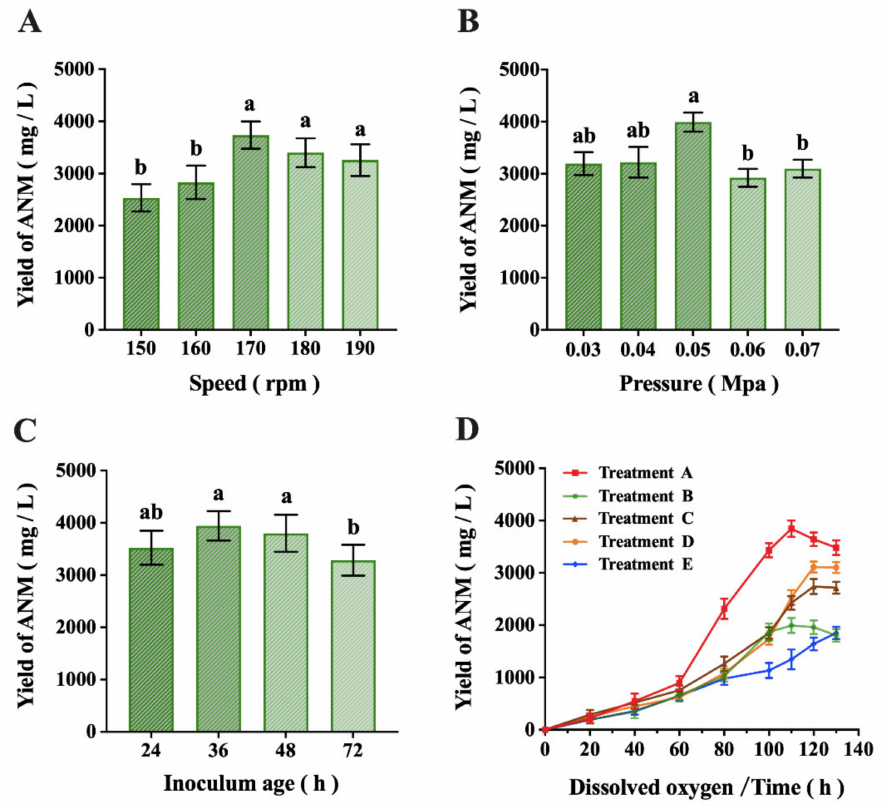
Figure 2. Results of industrial fermentation of SPRI-371 by speed, pressure, inoculum age and dis- solved oxygen. ( A ) Speed, rpm; ( B ) pressure, Mpa; ( C ) inoculum age, h; ( D ) dissolved oxygen/time, h. The data are shown as means ± SD of three independent experiments. Lowercase letters indicate significant differences ( p < 0.05) between any two